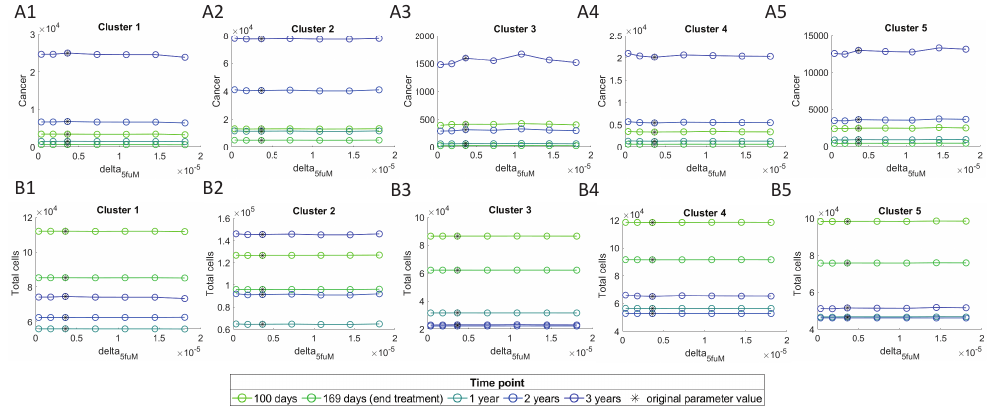
Figure 10. Cancer and total cells as a function of δ 5 fuM . ( A1 – A5 ) depict cancer cells and (B1 – B5 ) depict Total cells, at different time